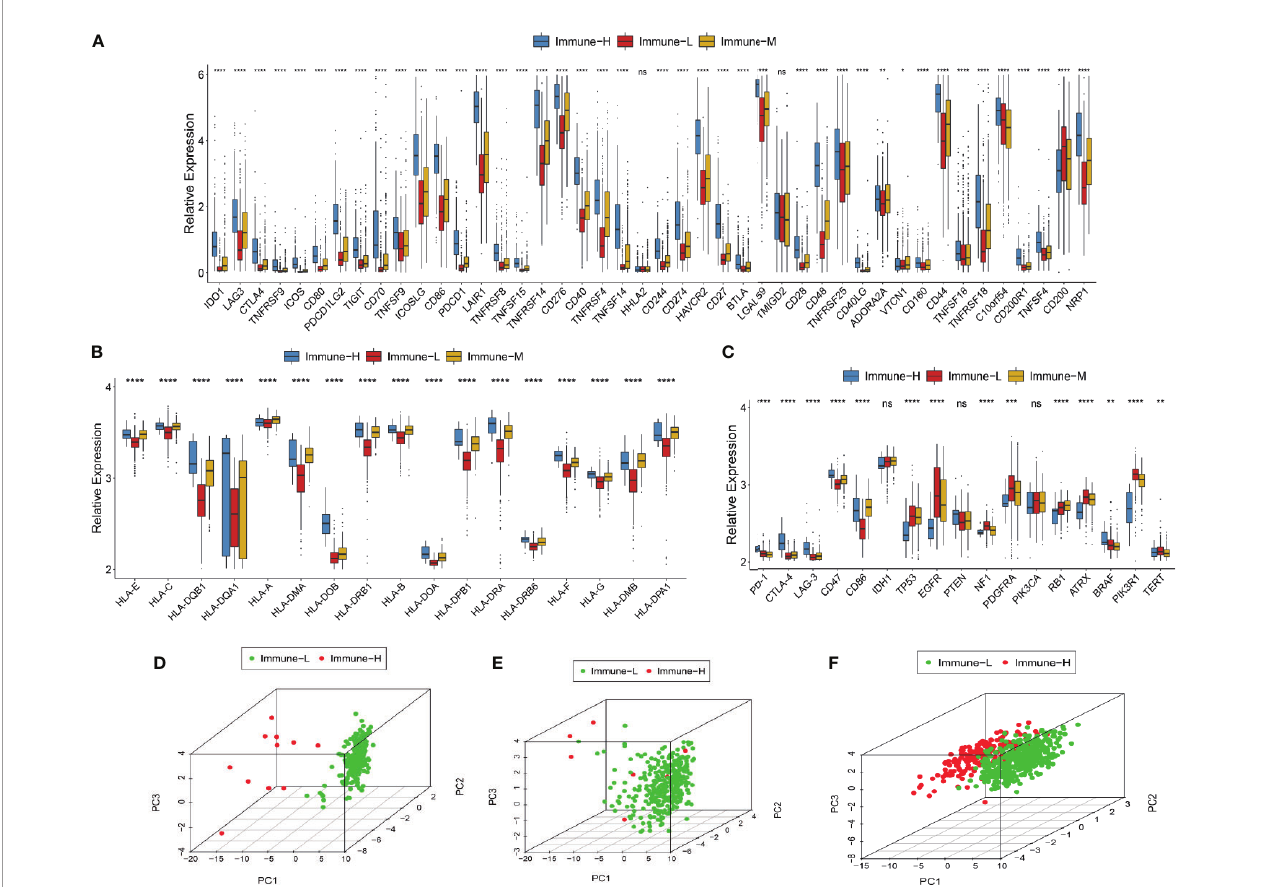
FIGURE 3 | Differences in checkpoints, HLA family and other key biomarkers between the immune phenotypes. (A) Expression of checkpoint family biomarkers of each phenotype in the CGGA RNA-seq cohort. (B) Expression of HLA family genes of each phenotype in the TCGA microarray cohort. (C) Expression of part T cells co-inhibitors checkpoints and key biomarkers relating to glioma biological behavior and pathways in the TCGA microarray cohort. The upper and lower ends of the boxes represented interquartile range of values. The lines in the boxes represented median value, and black dots showed outliers. The asterisks represented the statistical P value (*P < 0.05; **P < 0.01; ***P < 0.001; ***P < 0.0001, ns, not signi fi cant). (D – F) There was separation between the immune-H and immune-L phenotypes in the TCGA microarray (D) , TCGA GBM RNA-seq (E) and CGGA RNA-seq cohorts (F) according to PCA. PC1, PC2, PC3 represented three dimensions showing differential expression of markers related to immune cell